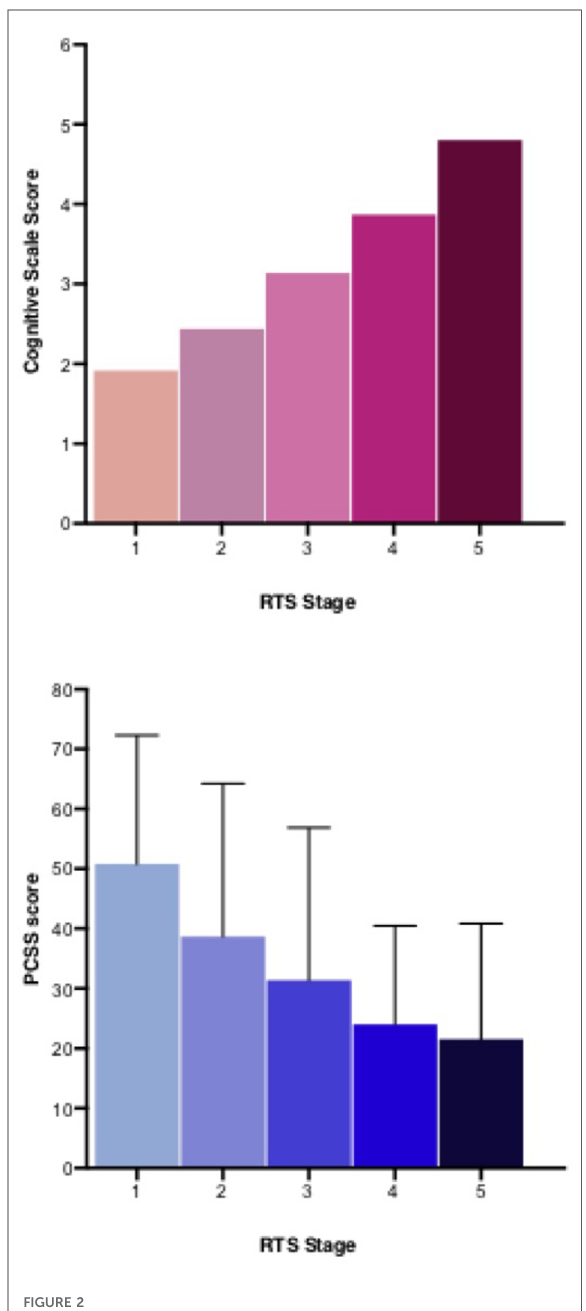
FIGURE 2 Post-concussion symptom scale (PCSS) and cognitive scale score at return to school stage entry.